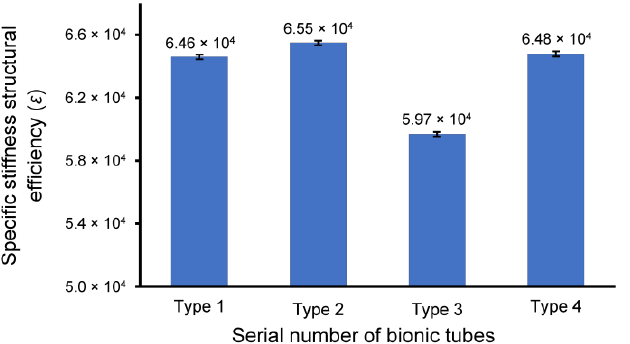
Figure 7. The specific-stiffness structural efficiency, ε , of the four bionic tubes. Mean ± standard deviations were depicted, n = 10.